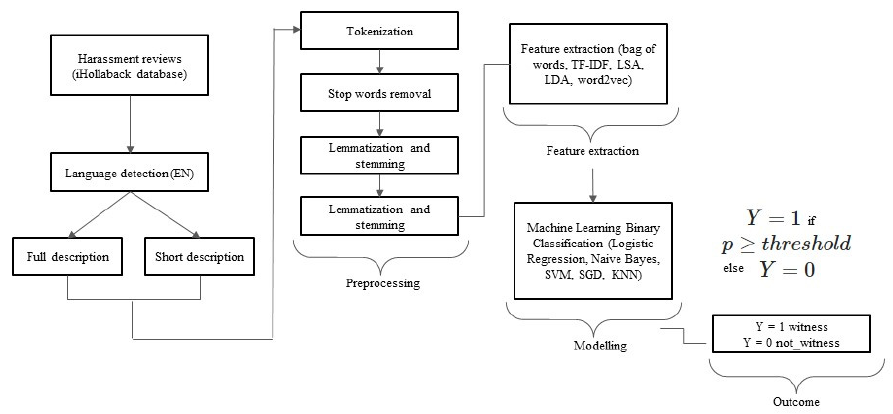
Figure 9. Workflow diagram of the harassment classification pipeline.